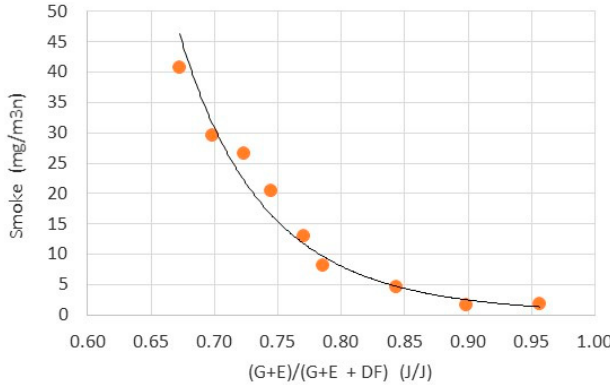
Energies 2020 , 13 , 6349 Figure 10. Smoke vs. 𝐺 + 𝐸 fraction by energy content. Figure 10. Smoke vs. G + E fraction by energy content.